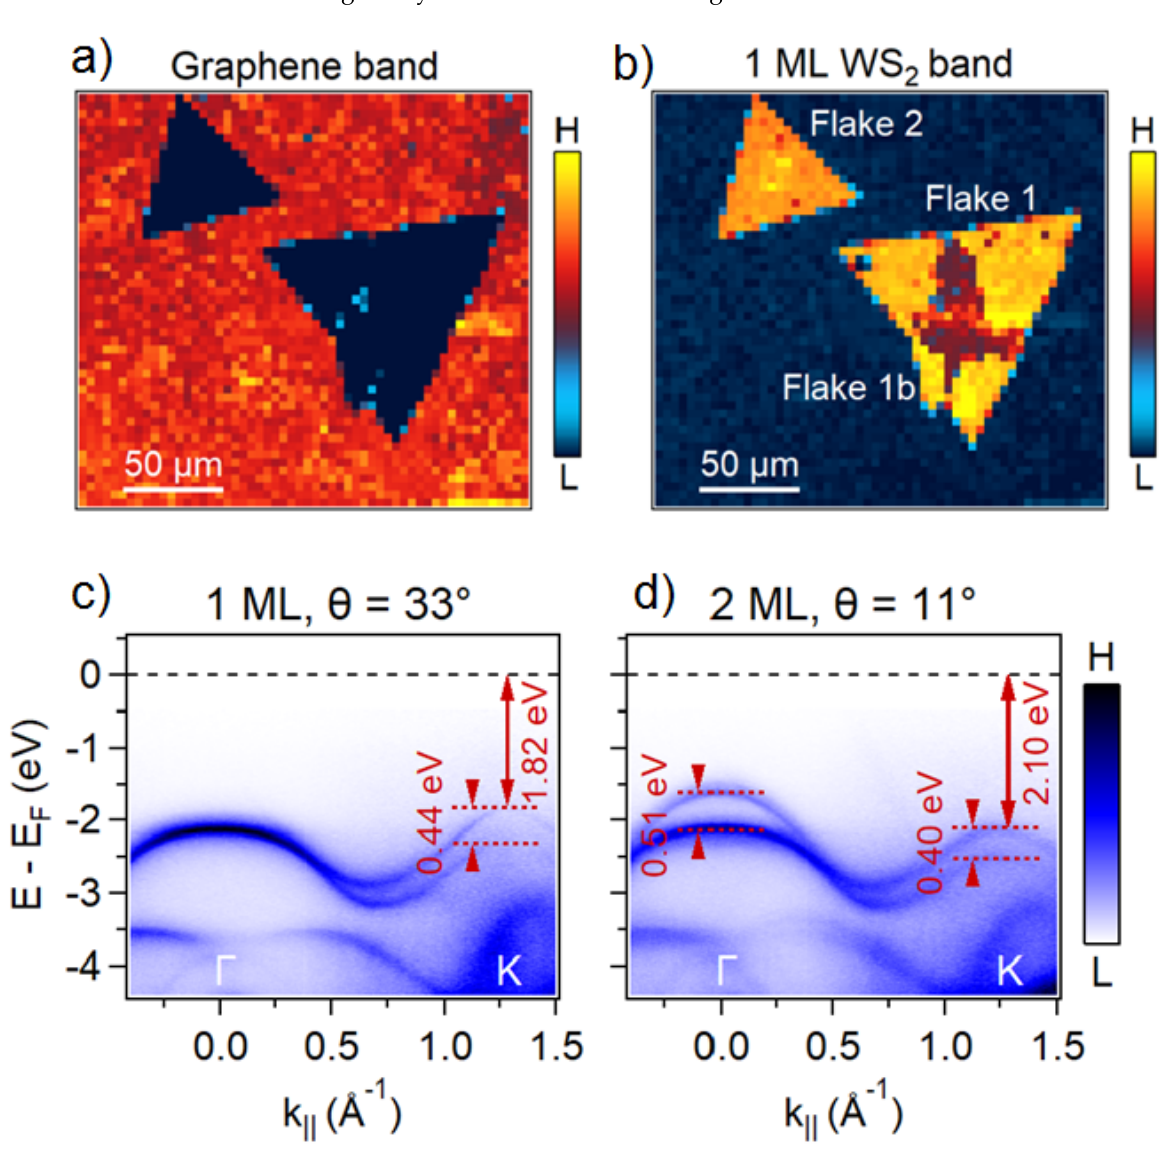
Figure 2. Comparison of the electronic band structure between single and bilayer WSe 2 : ( a , b ) Spatially resolved ARPES map of the π graphene band and the 1 Ml WS 2 band; ( c , d ) ARPES map of single and bilayer WS 2 along the Γ K high- symmetry directions.